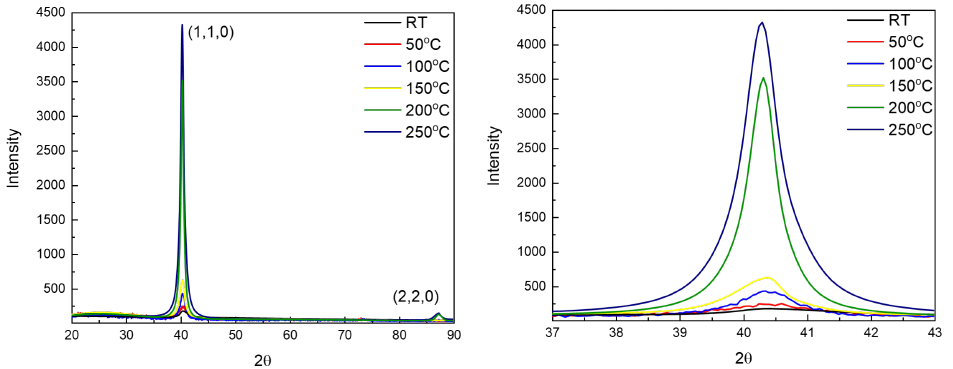
Figure A1. Broad XRD spectra of the sputtered molybdenum films ( left ) and the (110) peak ( right ) with varying substrate